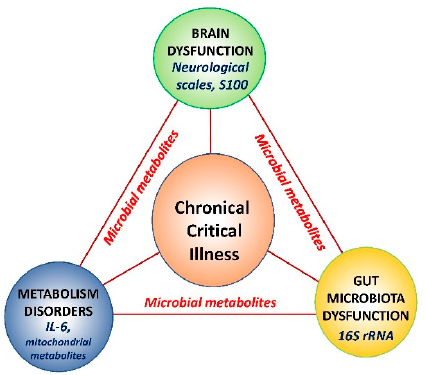
Figure 4. The schematic representation of the factors affecting the development of a chronic critical illness with the involvement of dysfunction of key organs—the brain and the gut (via gut microbiota), and the metabolic disorders, mediated by microbial metabolites.